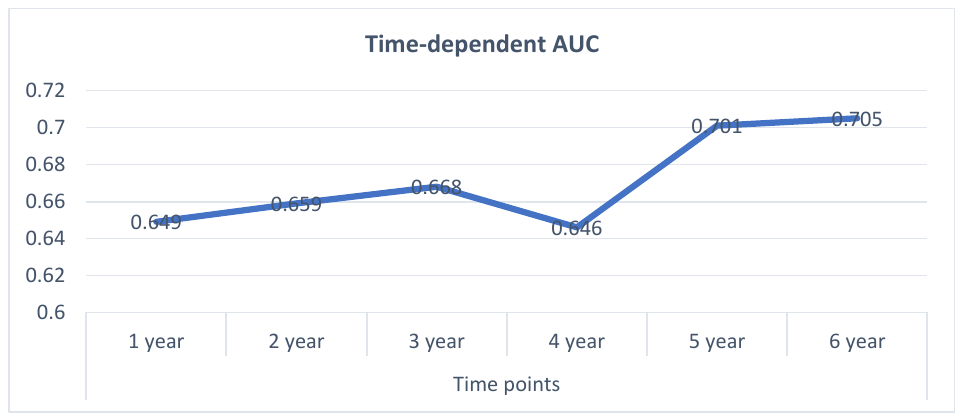
Table 3. Demographic and clinical characteristics of CRC cancers in train dataset.